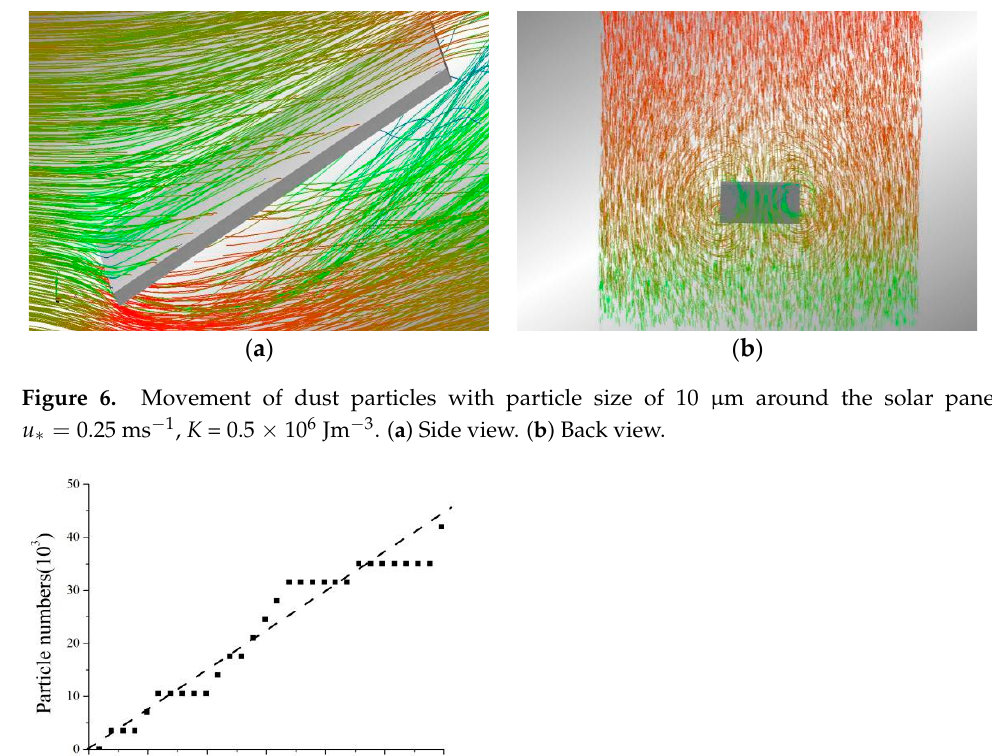
Figure 6. Movement of dust particles with particle size of 10 μ m around the solar panel, 1 0.25ms u * Figure 5. Velocity distribution around solar panel on different contour surfaces when 1